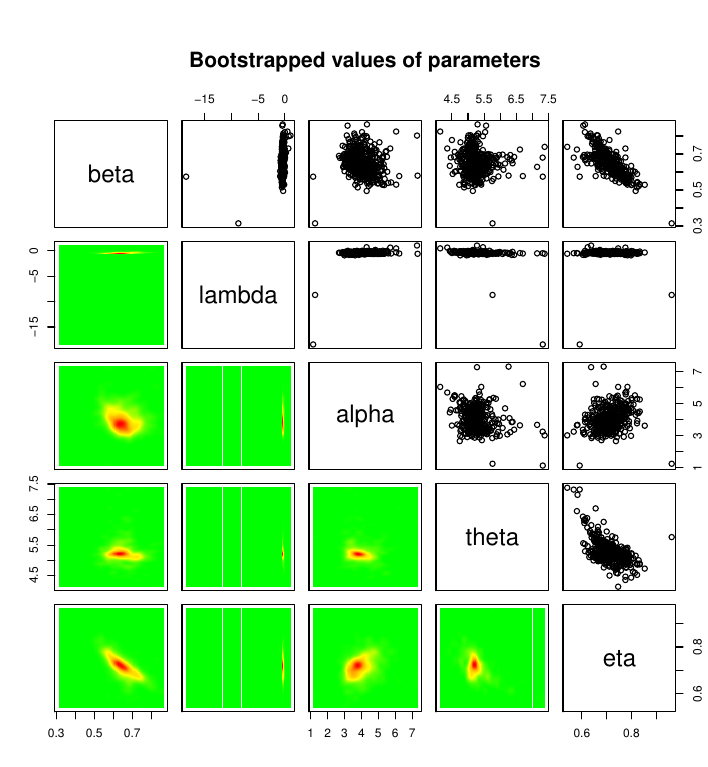
Figure 8 – Non-parametric bootstrapped values of parameters of GOTTS-E distribution for the second data